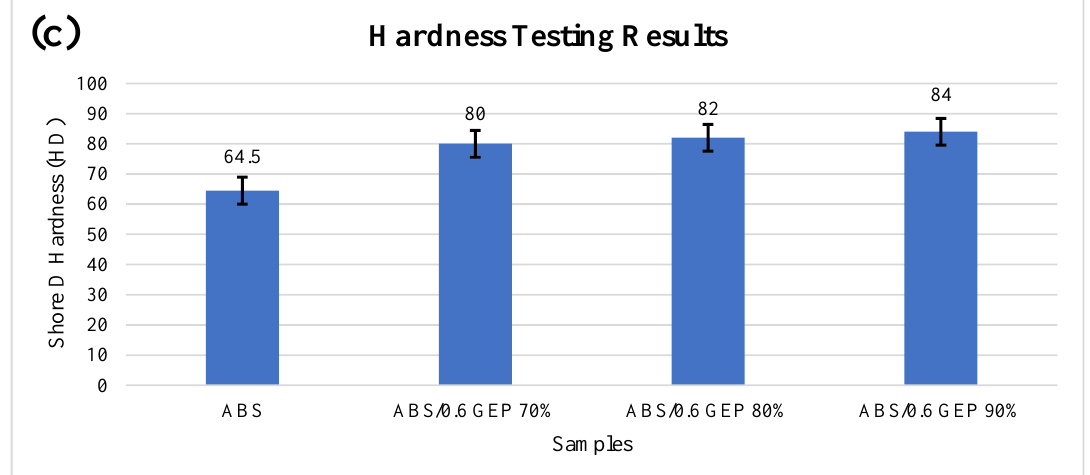
Figure 22. Hardness testing results: ( a ) ABS/0.2 GEP composites with ABS; ( b ) ABS/0.4 GEP composites with ABS; ( c ) ABS/0.6 GEP composites ABS.